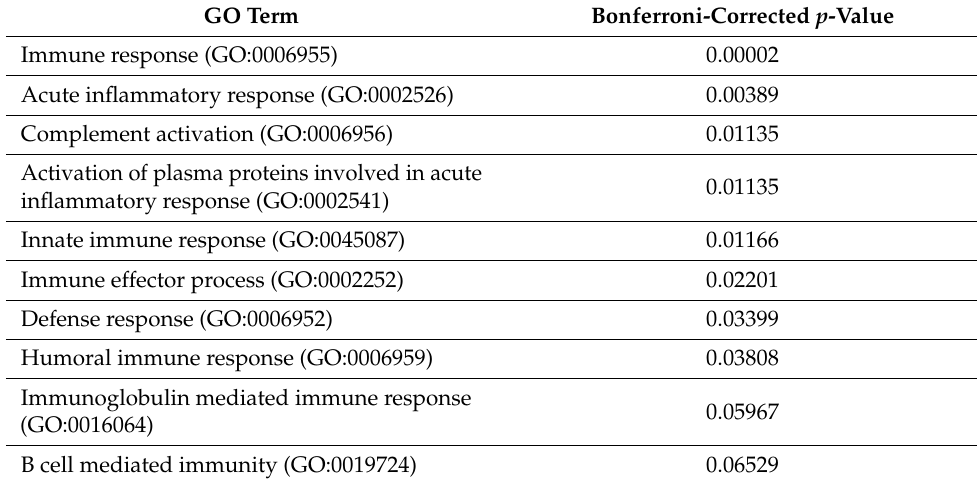
Table 3. The 10 most significant biological process GO terms that correspond to the 40 genes up- regulated in cryptococcal